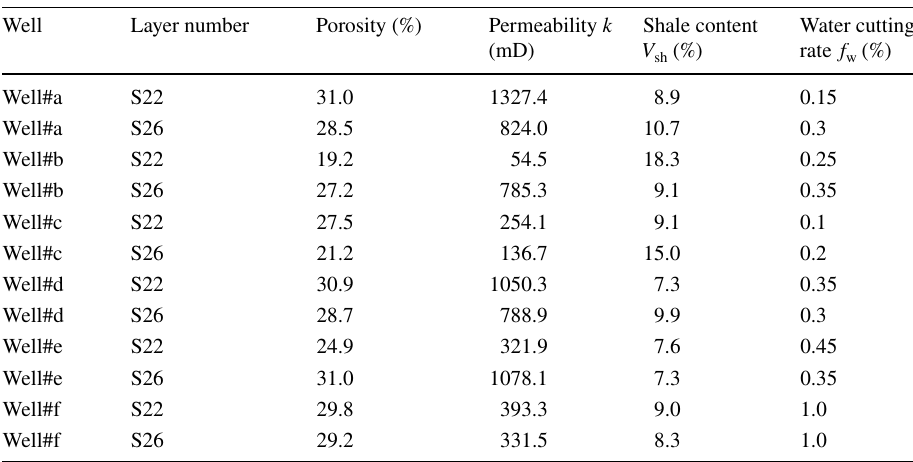
Table 4 Reservoir parameters calculated from logging data and current water cutting rates of S22 and S26 in the injection- production